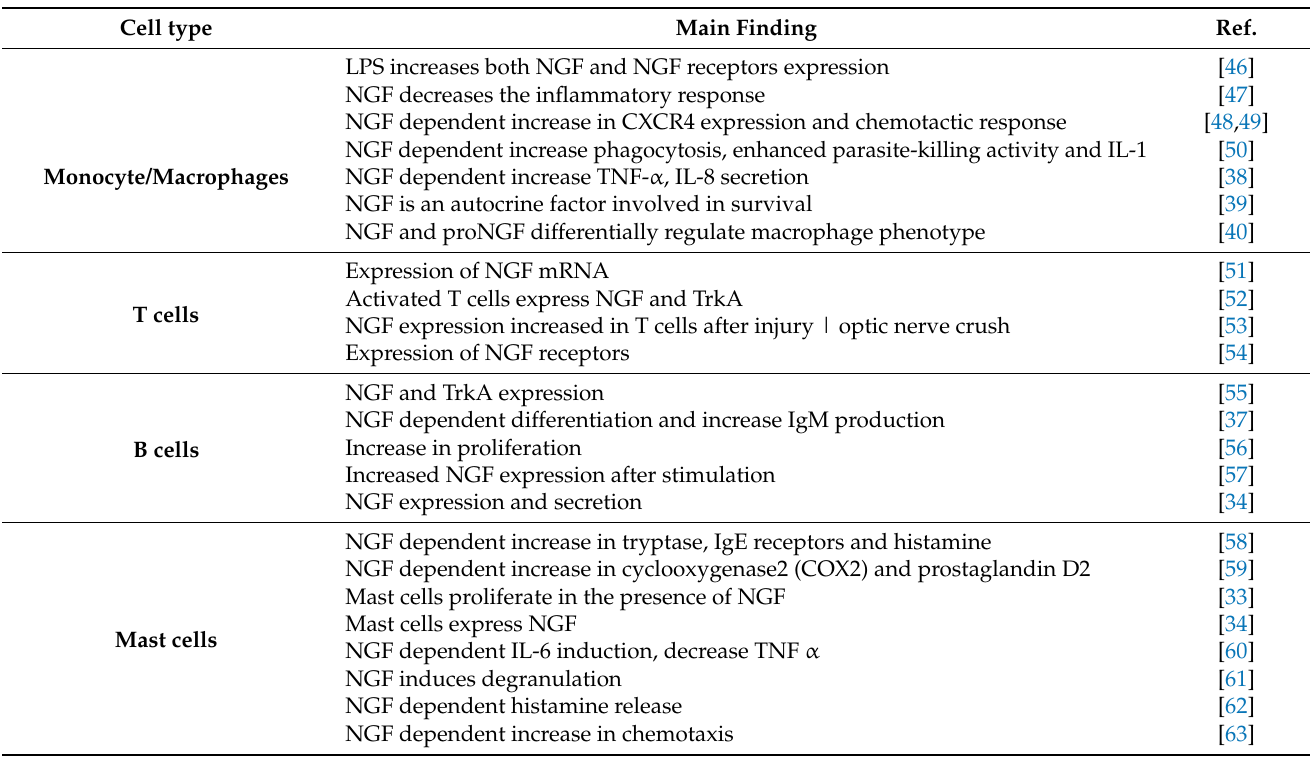
Table 1. NGF-responsive immune